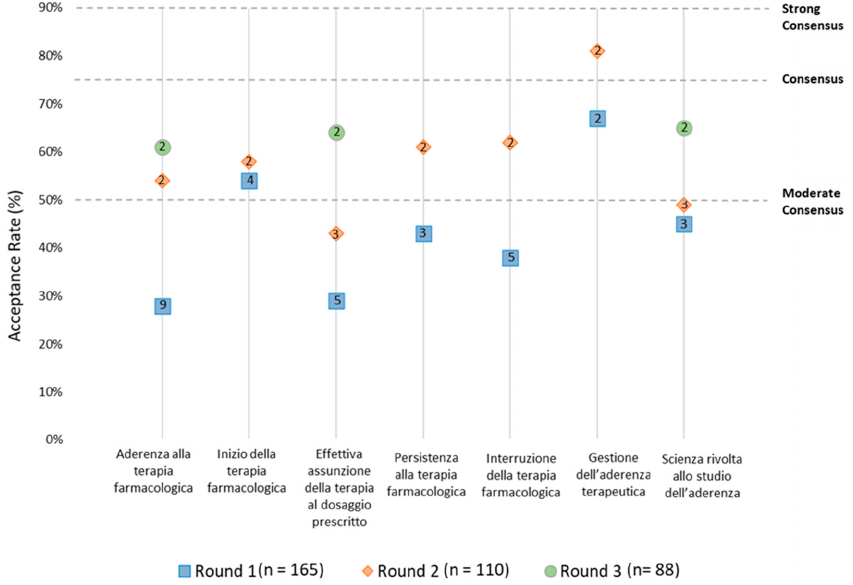
Figure 4. Preferred Italian terms per Delphi round with the number of proposed items in the icon (numbers in the boxes are representing the amount of different translations proposed for each